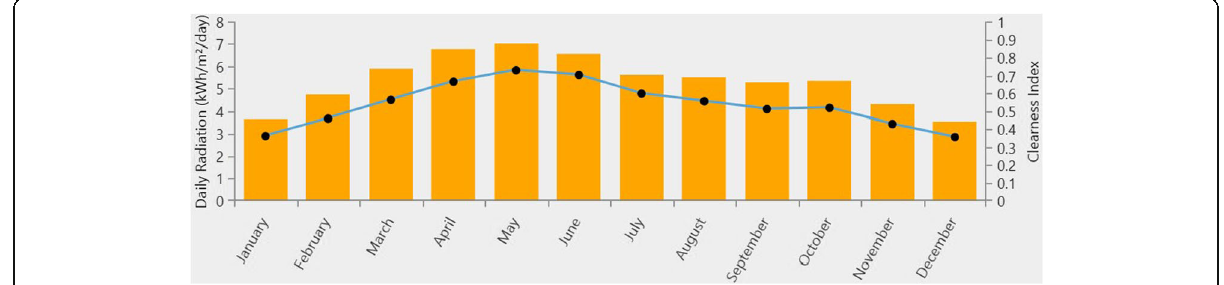
Fig. 5 Variation in monthly average solar global horizontal irradiance data